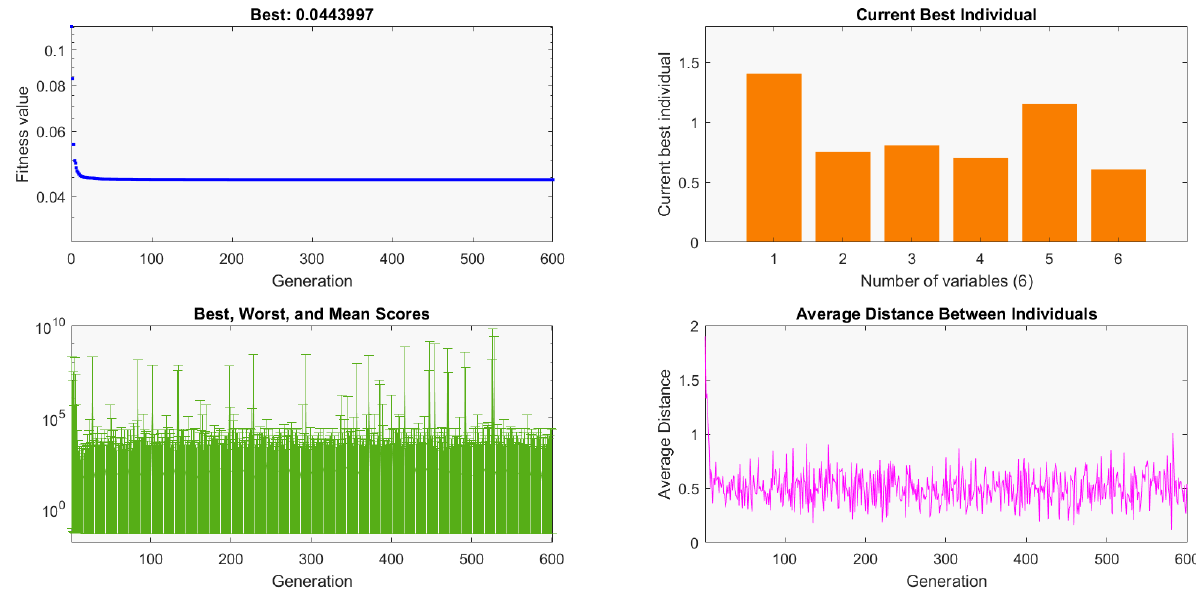
Figure 5. Results of Problem 1 in terms of learning curve, best individual scores, and average distance for 0.1 noise level.